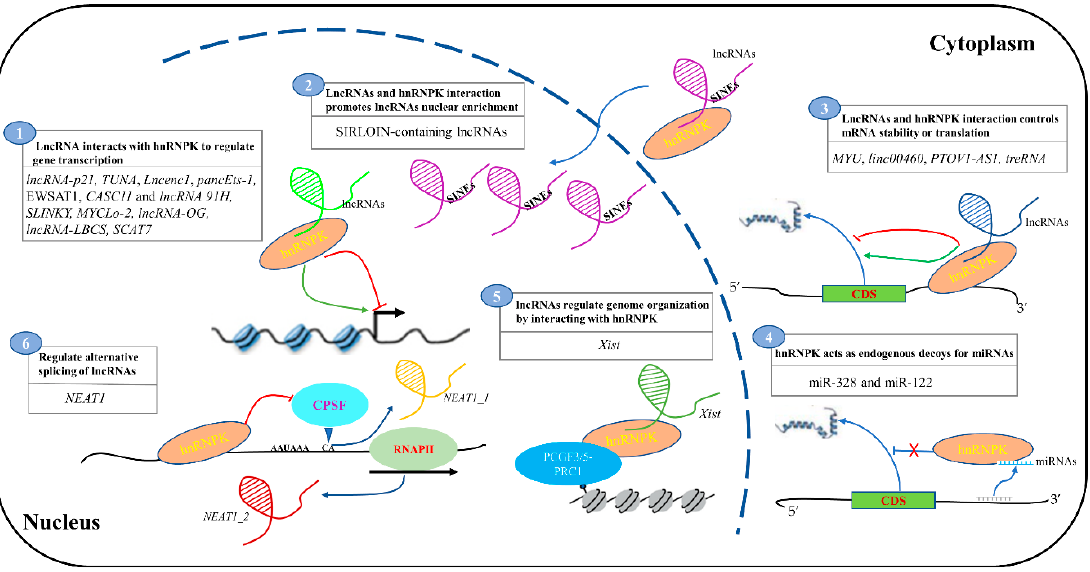
Figure 1. The molecular mechanisms of ncRNAs and hnRNPK interplay in regulating gene expression. (1) long non-coding RNAs (lncRNAs) recruit hnRNPK and promote or restrain gene expression.